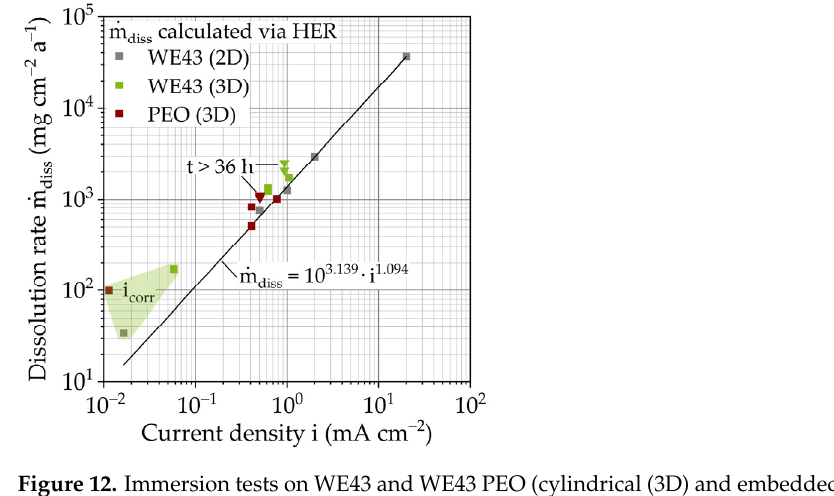
Figure 12. Immersion tests on WE43 and WE43 PEO (cylindrical (3D) and embedded (2D) specimens) in 0.9% NaCl solution at 36.5 °C. Dissolution rates calculated via hydrogen evolution rate (HER) of immersion tests with and without galvanostatic anodic polarization. Results of the embedded samples originate from [31].